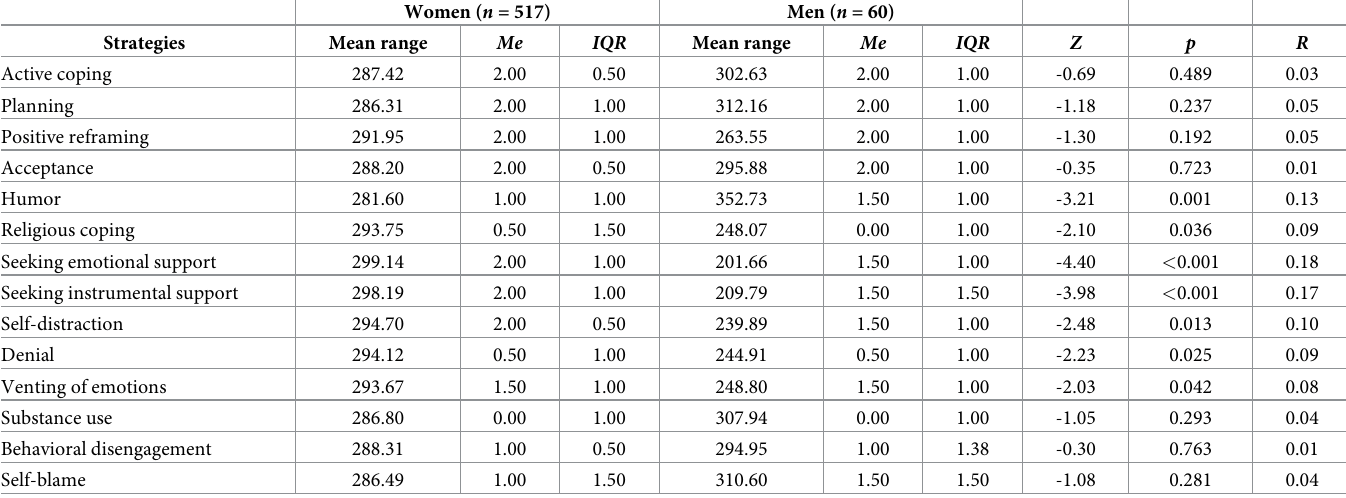
Table 6. Gender differences in strategies of coping with